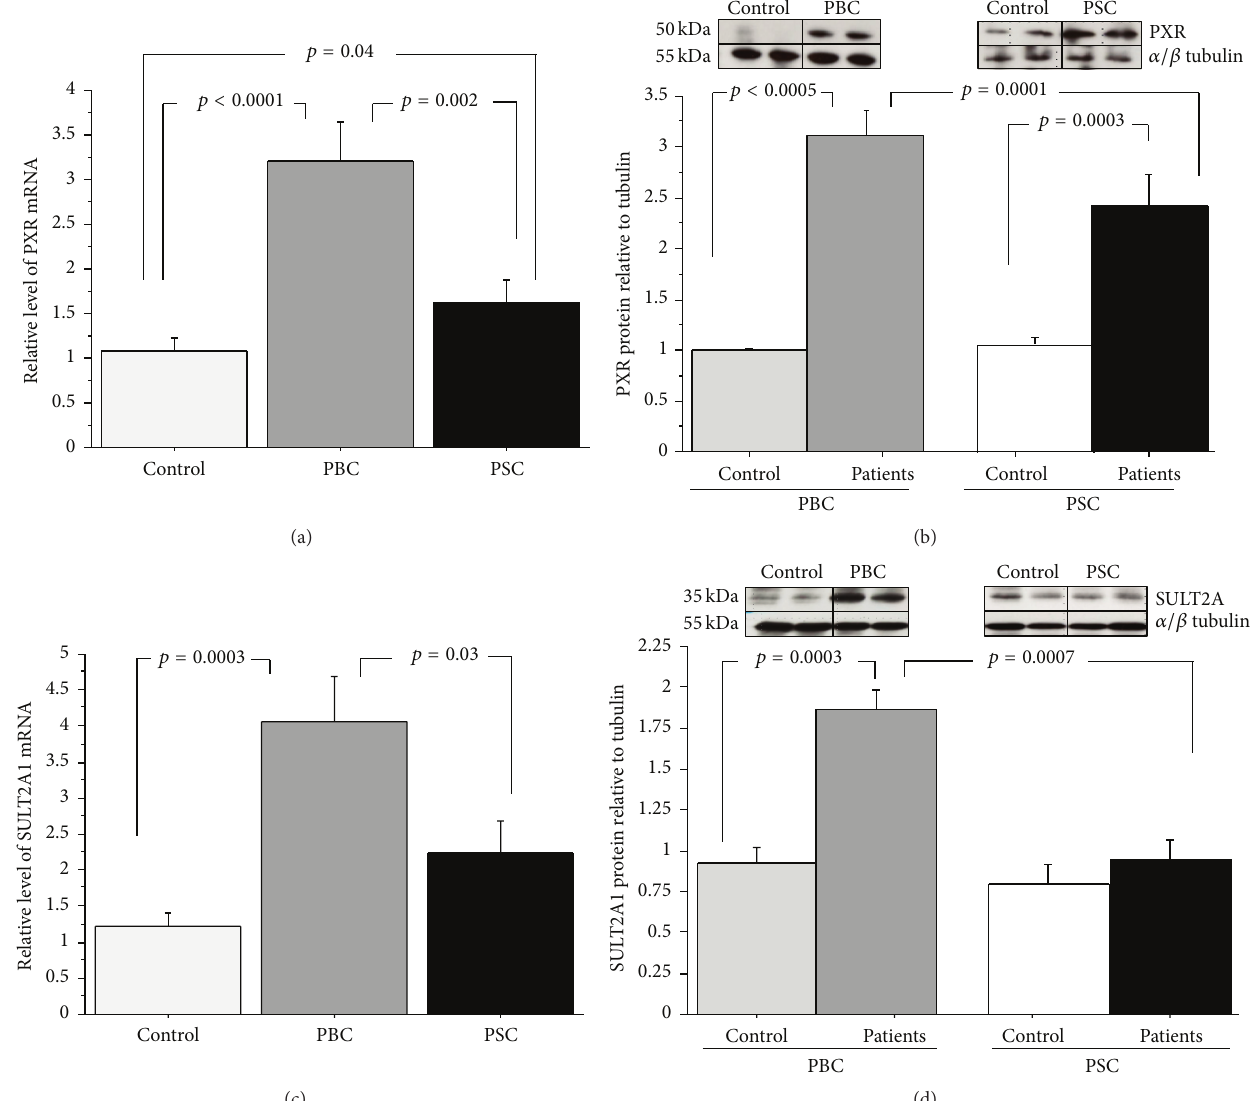
Figure 2: Liver expression of PXR and SULT2A1 in liver tissue from patients with cirrhotic PSC and PBC. (a) PXR mRNA, (b) PXR protein, (c) SULT2A1 mRNA, and (d) SULT2A1 protein. Levels of gene expression presented as fold-change relative to control were normalized with glyceraldehydes 3-phosphate dehydrogenase (GAPDH). Bars indicate the mean ± SEM. Changes in protein levels were determined by densitometry analyses after normalization to 𝛼 / 𝛽 tubulin as a control for loading. Bars indicate the mean ±